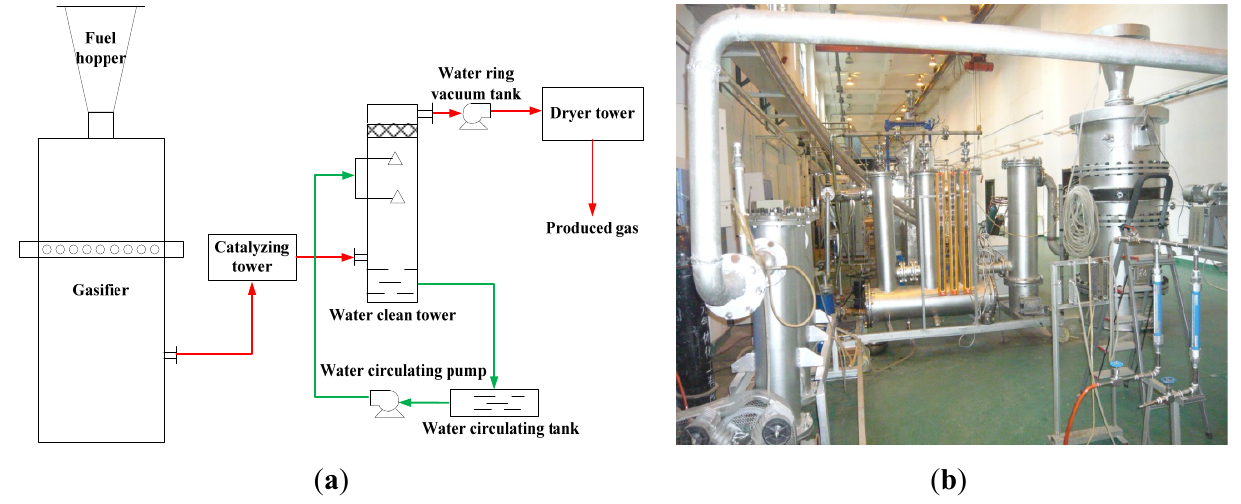
Figure 3. Fixed bed gaisifer subsystem for biomass gasification. ( a ) Flow diagram; ( b ) Test